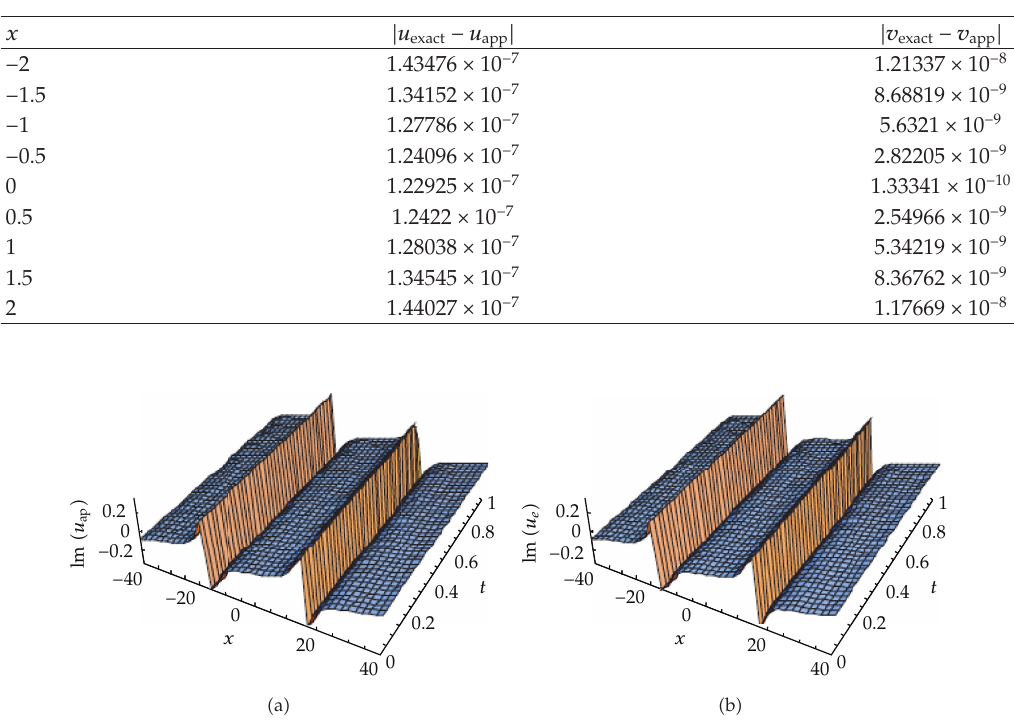
Table 3: The approximate solutions (cid:2) 5.19 (cid:3) and (cid:2) 5.20 (cid:3) in comparison with the exact solutions (cid:2) 5.14 (cid:3) and (cid:2) 5.15 (cid:3) , respectively, if t (cid:7) 0 . 5, k (cid:7) 0 . 1, c (cid:7) 0 . 2.